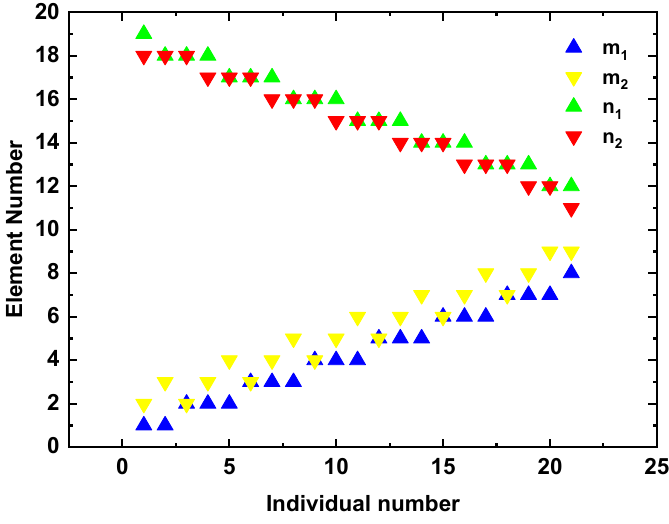
Figure 9. Allocation of element number to each stage in different individual number.